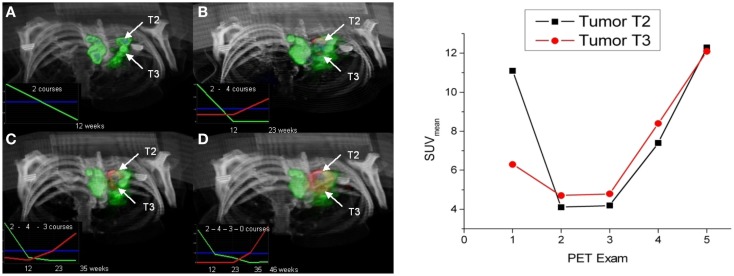
Left: 3D visualization of two tumors (T2 and T3) using parametric imaging with three basis functions: stable (blue), decreasing (green), and increasing (red) represented in the left corner of each image (the number of chemotherapy courses between each PET exam is mentioned). Parametric imaging using 2 (A), 3 (B), 4 (C), and 5 (D) exams. Right: SUVmean evolution (calculated within a ROI defined by 40% of SUVmax) for the two tumors. Note that the non-responding T2 tumor was detected with parametric imaging earlier (exam 2) than applying EORTC criteria that concluded to a stable disease between exam 2 and 3. Reprinted by permission of Necib (Ph.D Thesis).